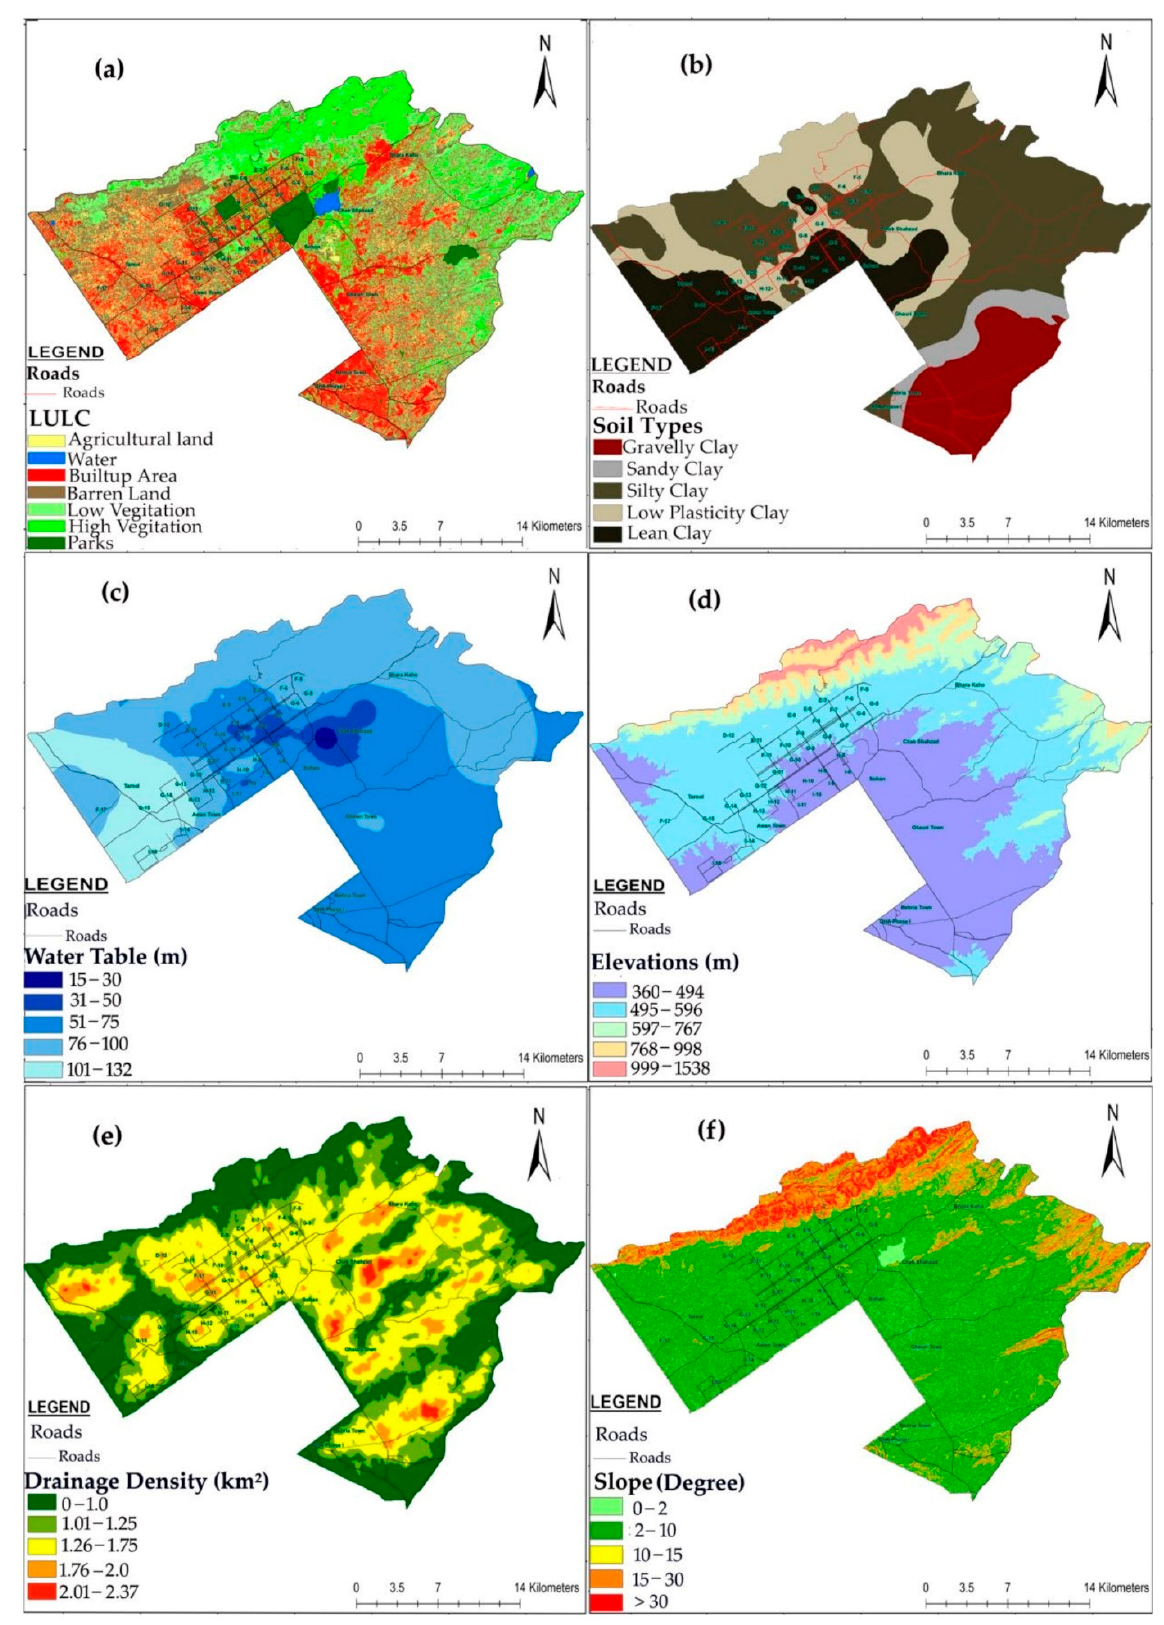
Figure 2. Criteria/factors maps ( a ) LULC, ( b ) soil ( c ) water table, ( d ) elevation, ( e ) drainage density, and ( f ) slope.